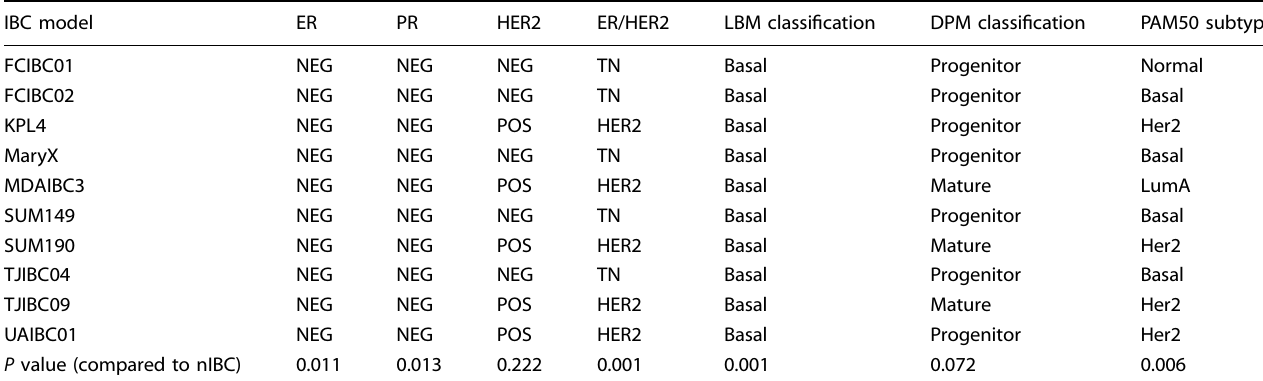
Table 1. Molecular characteristics of IBC